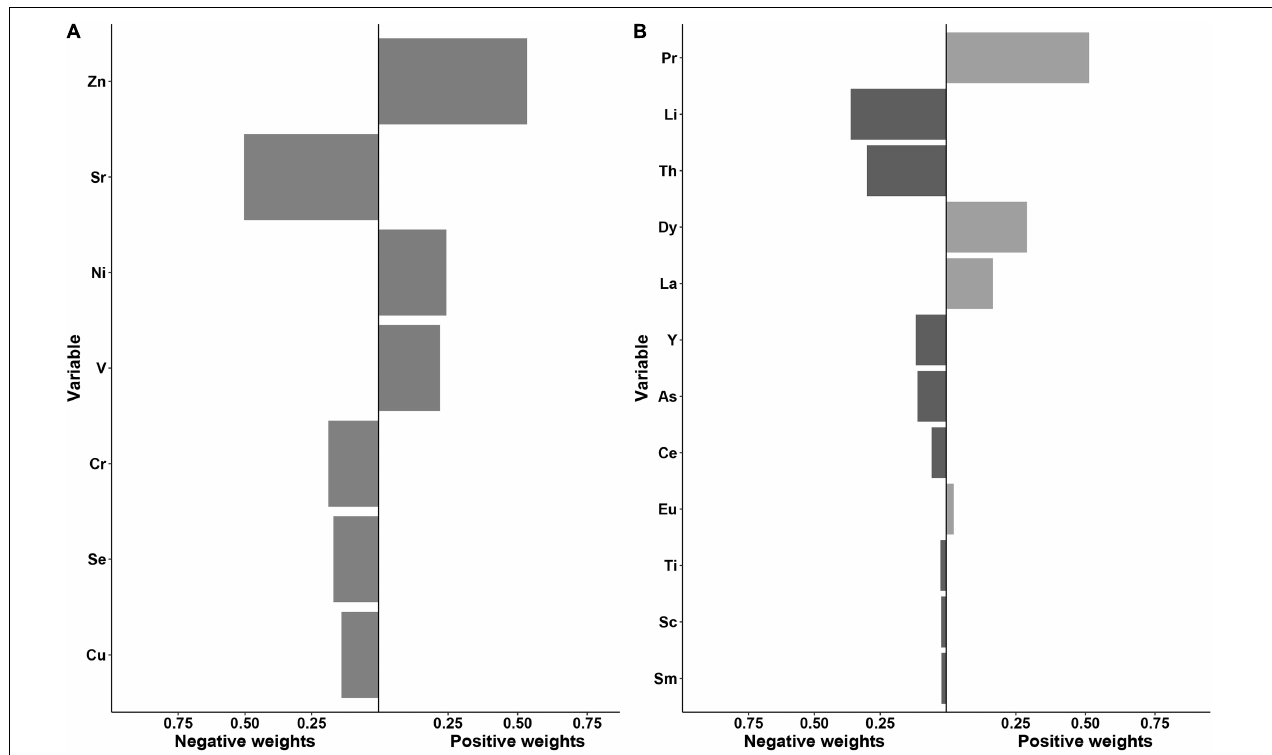
FIGURE 3 | Weights representing the proportion of the positive or negative partial effect for each metal in the quantile g-computation model with (A) the essential metals and (B) the non-essential metals.